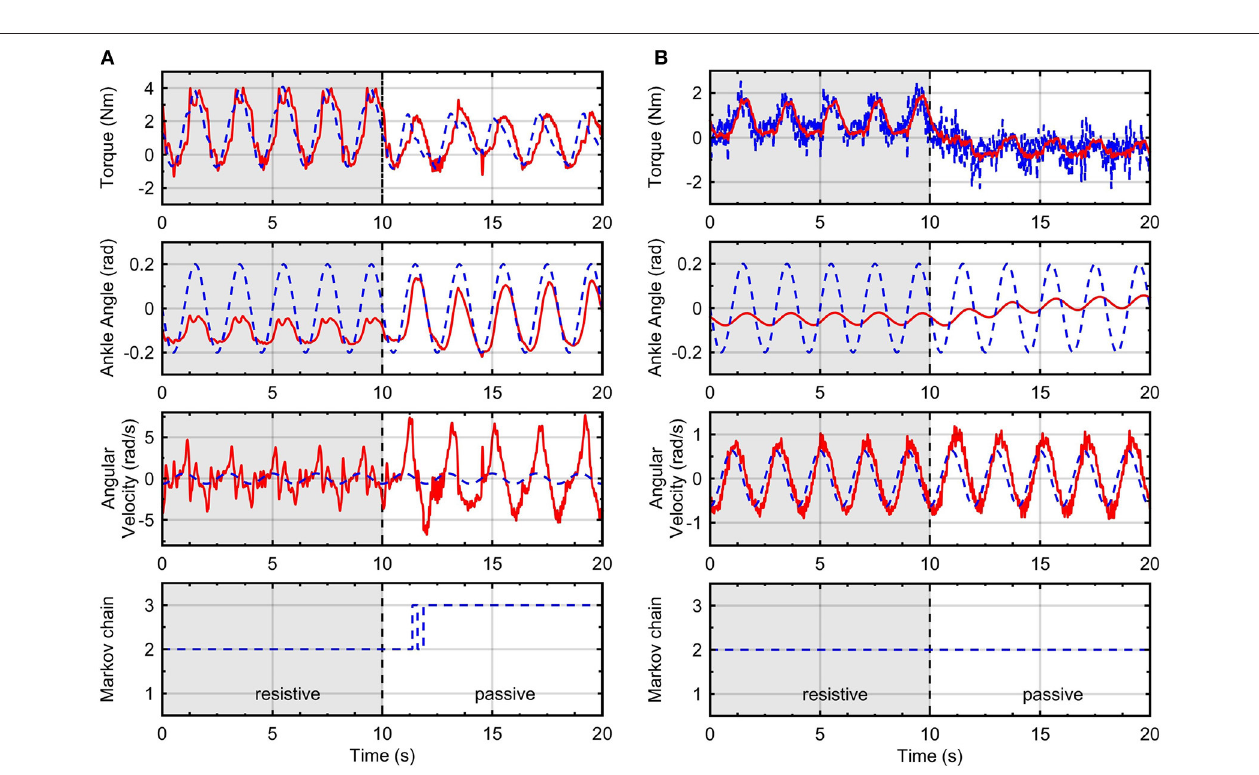
FIGURE 9 | Frequency closed-loop response of the system with force control. (A) H ∞ force control. (B) Recursive RR-DMJLS force control. Graphs show responses for passive (blue) and resistive (red) modes.